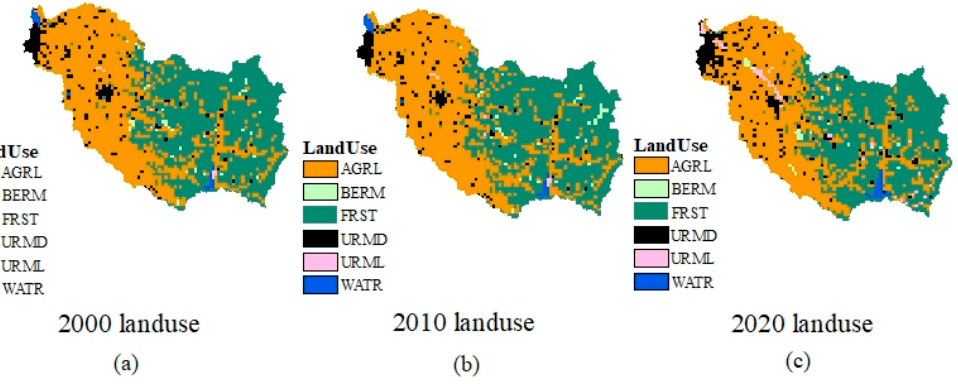
Figure 3. Map of land use. ( a ) Ashe River 2000 Land Use Map, ( b ) Ashe River 2010 Land Use Map, ( c ) Ashe River 2020 Land Use Map.